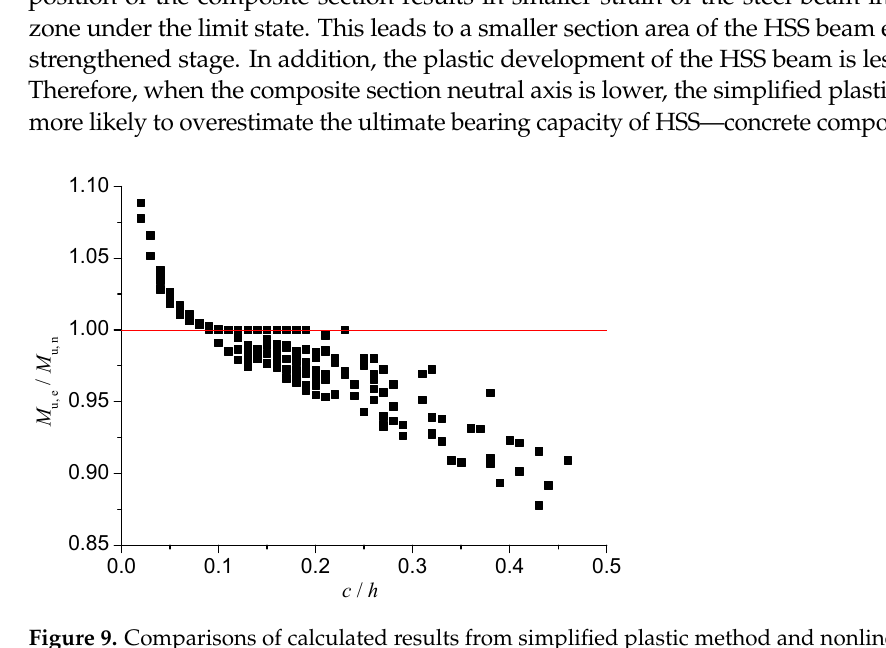
Figure 10. Comparison between the calculated results from modified plastic method and nonlinear method. To further verify the accuracy and applicability of modified plastic method, the experimental results were compared to the calculation results (Table 5). It is found that ultimate bending strength of HSS—concrete composite beams calculated by the modified plastic method agree well with the experimental results.